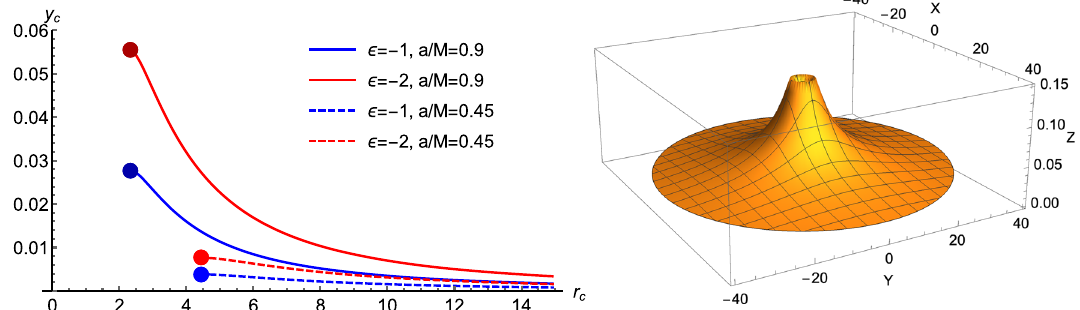
Fig. 2 (Left): In the presence of the deviation function ˜ (cid:2)( y ) , the circu- lar motion of a massive particle moving around the black hole is associ- ated with a polar angle θ c which is not π/ 2. The value of θ c depends on theradiusofthecircularorbit r c .Inthisfigure,wechoose ˜ (cid:2)( y ) = (cid:2) May , namely, n = 1 in Eq. (7). All curves approach the standard equatorial plane y c → 0 when r c gets large. Also, each curve terminates at the ISCOs where the radial instability starts to occur (see the circular points